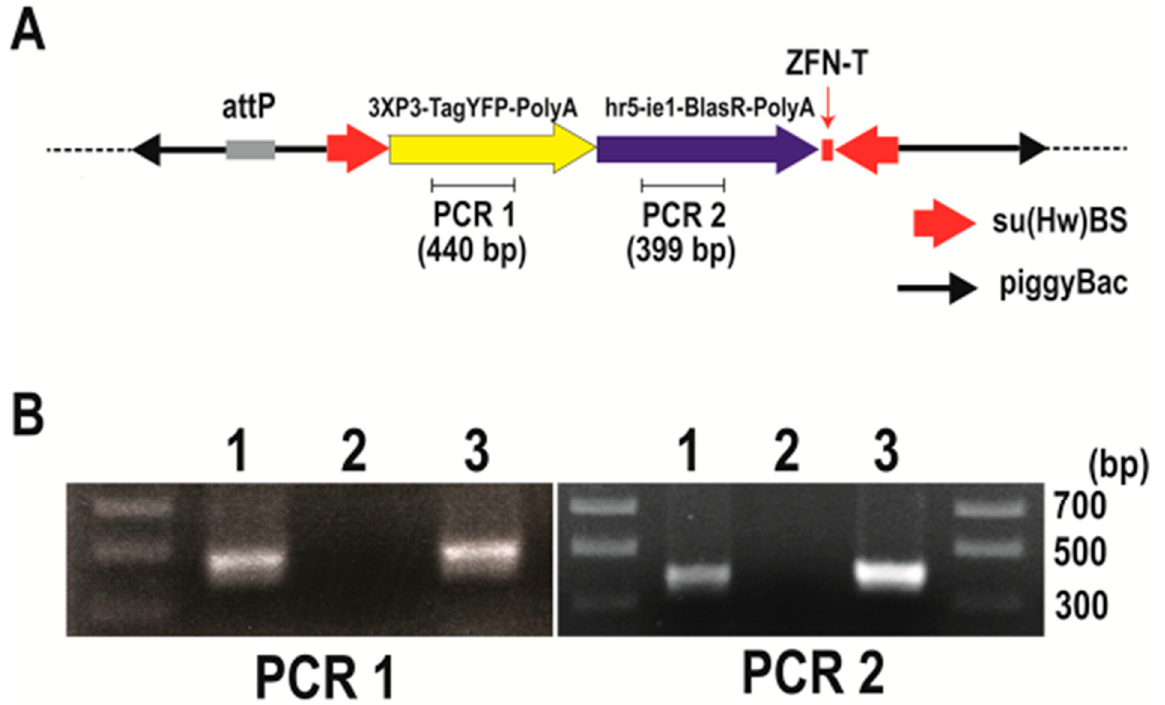
Figure 3. Confirmation of integration into the Bradysia ( Sciara) genome by pBac [3XP3-TagYFP, hr5-ie1-BlasR, su(Hw)BS] attP-ZFN-T. ( A ) Schematic depiction of pBac [3XP3-TagYFP, hr5-ie1-BlasR, su(Hw)BS] attP-ZFN-T. ( B ) Genomic PCR to amplify the TagYFP coding sequence (PCR1) and blasticidin resistance gene coding sequence (PCR2). The gel lanes contain genomic DNA from Drosophila transformants carrying pBac [3XP3-TagYFP, hr5-ie1-BlasR, su(Hw)BS] attP-ZFN-T (lane 1), genomic DNA from uninjected Bradysia ( Sciara) larva as a negative control (lane 2) and genomic DNA from Bradysia ( Sciara) transformant line 1 (lane 3).